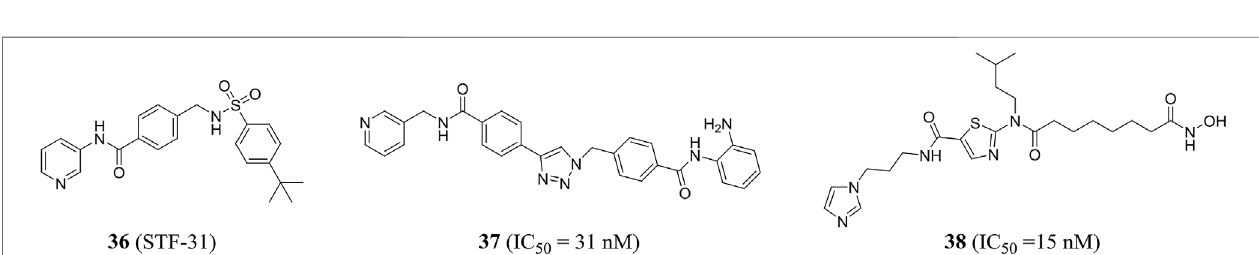
FIGURE 9 | Chemical structures and kinase activities of NAMPT inhibitors 36 – 38 .